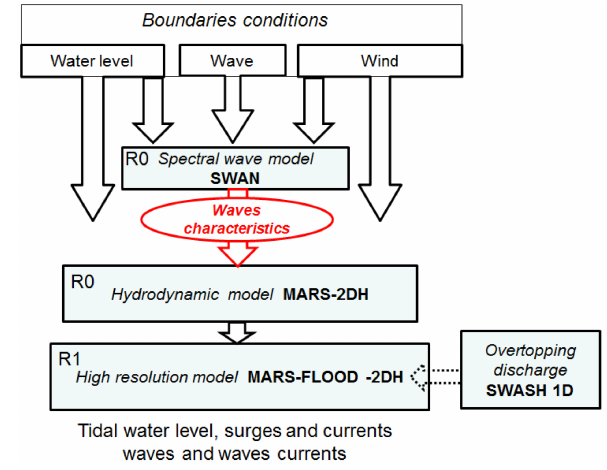
Figure 3. Chained modelling